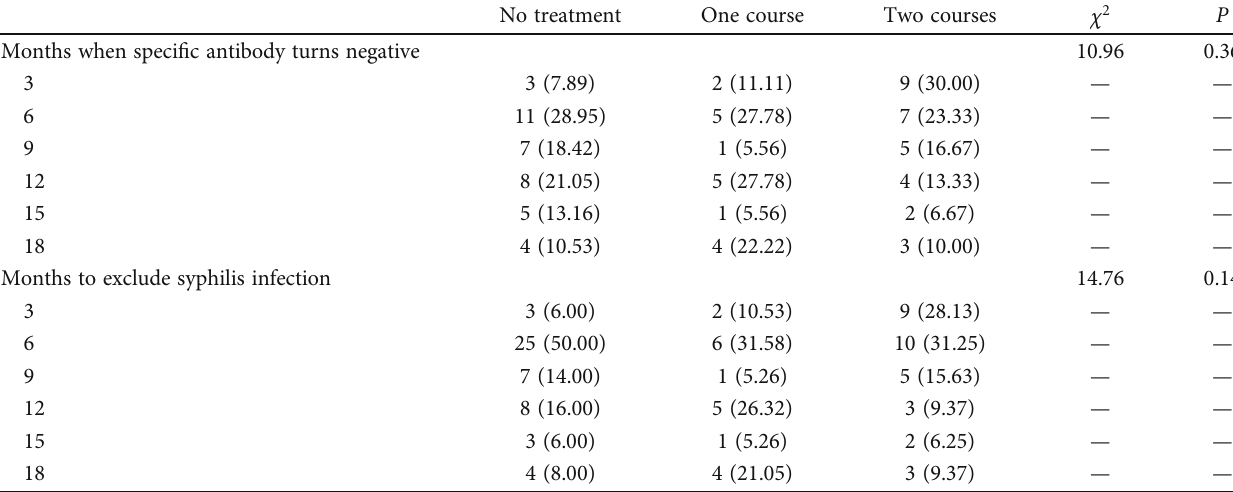
Table 8: Comparison of results features with or without treatment of pregnant women with syphilis with fi xed serological titers during